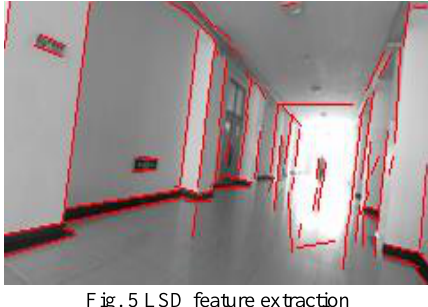
Fig. 5 LSD feature